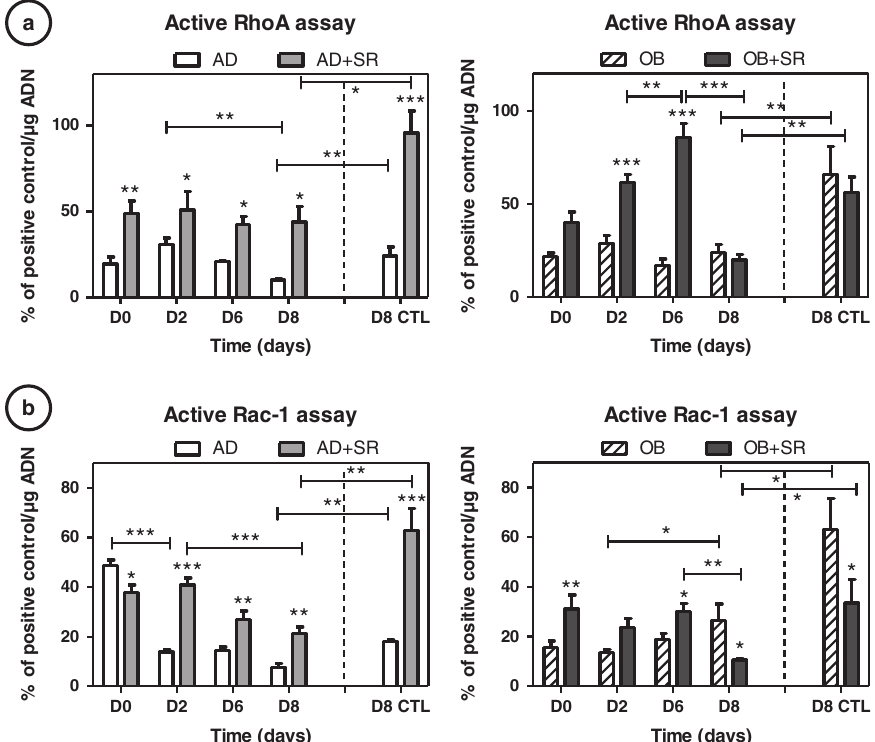
Fig. 3 Strontium (SR) regulates RhoA and Rac-1 activities in commited adipocytes and osteoblasts: C3H10T1/2 cells were cultured 2, 6 and 8 days in adipogenesis (AD) or osteogenesis (OB) media and simulated-microgravity, with or without 5 mM strontium. Cells were then harvested for G-LISA assays of RhoA ( a ) and Rac1 ( b ). Day 8 of control static condition corresponds to the D8 CTL data. Positive controls for RhoA and Rac1 activities are provided in the assay kit, activities of RhoGTpases data were normalized by this positive control. Error bars represent S.E.M. * p < 0.05, ** p < 0.01 and *** p < 0.001 compared to media without strontium, or compared to conditions indicated by the horizontal bars ( N = 4independant